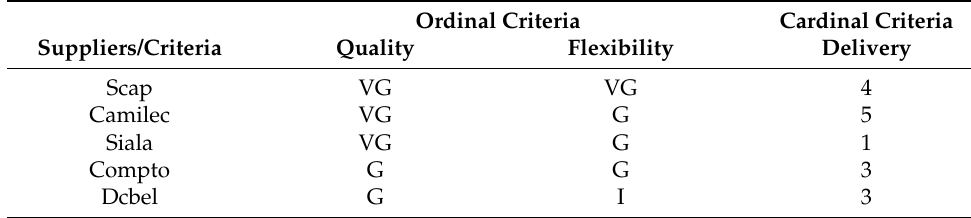
Table 2. Performance Decision Matrix. Ordinal Criteria Cardinal Criteria